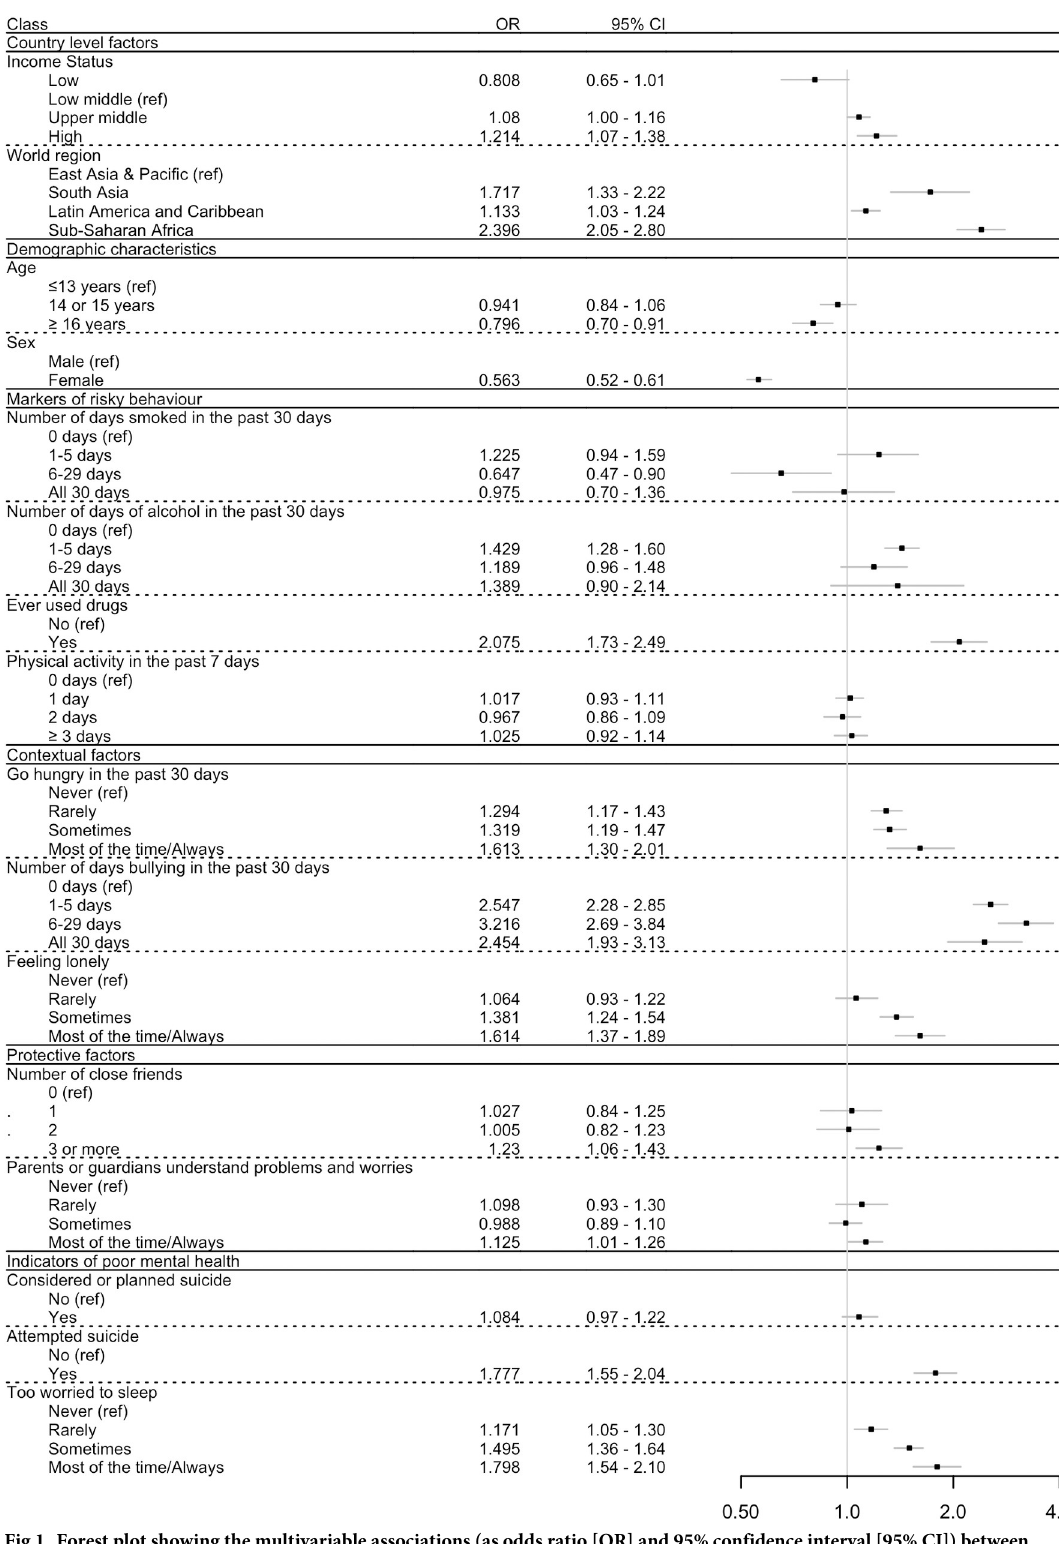
PLOS Medicine| https://doi.org/10.1371/journal.pmed.1003722 September 28,